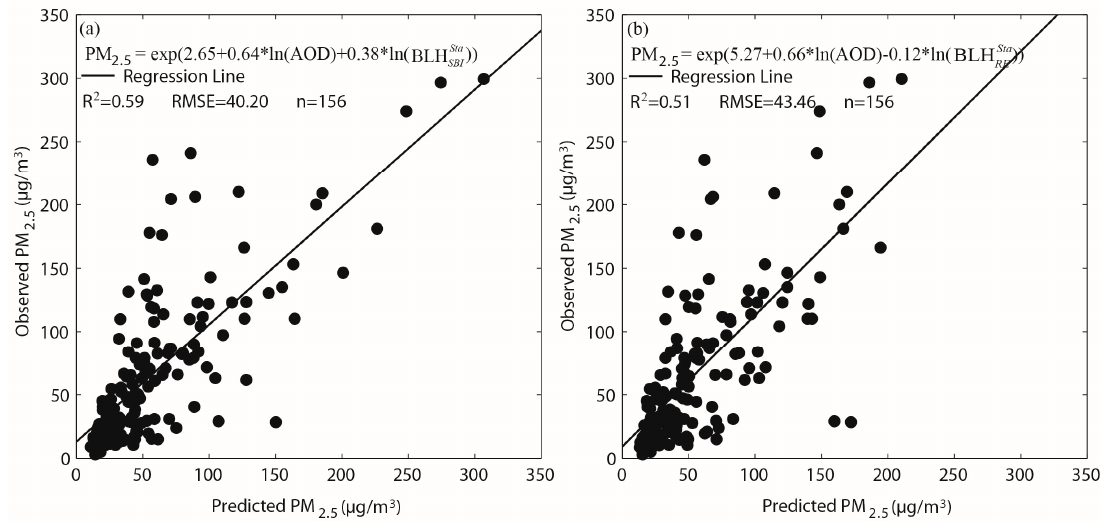
Figure 7. Scatter plots of the observed vs. the predicted surface PM 2.5 concentrations from the M-II-Sta with BLH (cid:2903)(cid:2886)(cid:2893)(cid:2903)(cid:2930)(cid:2911) ( a ) and BLH (cid:2902)(cid:2889)(cid:2903)(cid:2930)(cid:2911) ( b ).